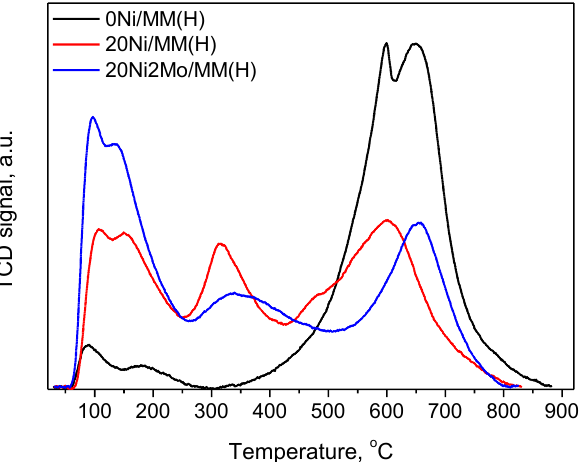
Figure 10. NH 3 -TPD profiles of 0Ni/MM(H), 20Ni/MM(H) and 20Ni2Mo/MM(H) samples. Figure 11 indicates that the addition of the Mo promoter to a nickel catalyst supported on montmorillonite favors the reduction of the Ni phase, in accordance with the electron diffraction results (Figure 5). Regarding the Mo species, the XPS analysis of the Mo3d peaks revealed that most of the Mo species are in the oxidation states (VI) and (V), while only a few are in the metallic state.